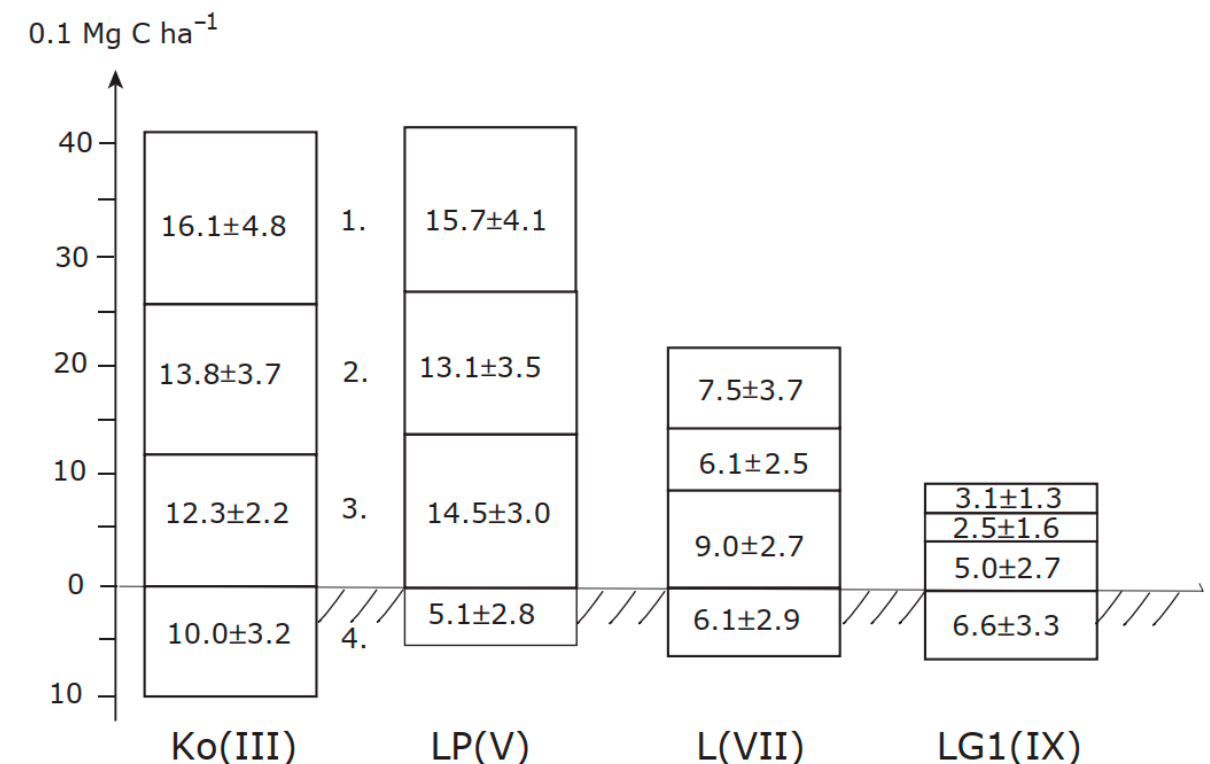
Figure 4. Annual organic carbon increases of aboveground compartments of phytocoenoses, in 0.1 Mg OC ha − 1 yr − 1 . Studied phytocoenoses–Ko(III), LP(V), L(VII) and LG1(IX), respectively, soil code and group number (in brackets); compartments of phytocoenosis 1—foliage of tree layer, 2—branches of tree layer, 3—stems of tree layer, and 4—ground vegetation.